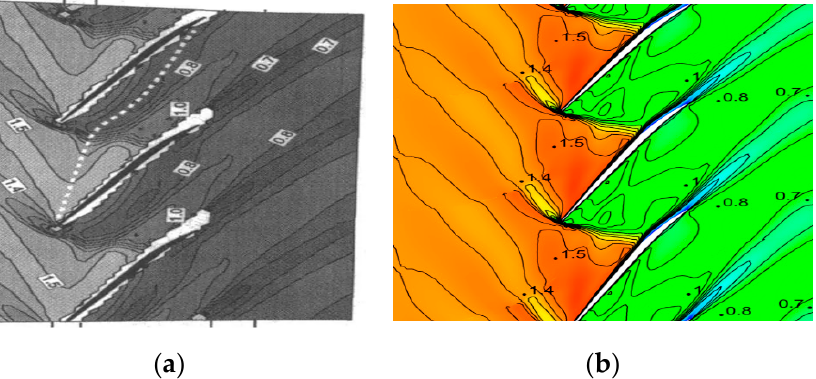
Figure 2. The comparison of the relative Mach number at 95% span of the maximum efficiency point. ( a ) the experimental results [25]. ( b ) the numerical simulation results.